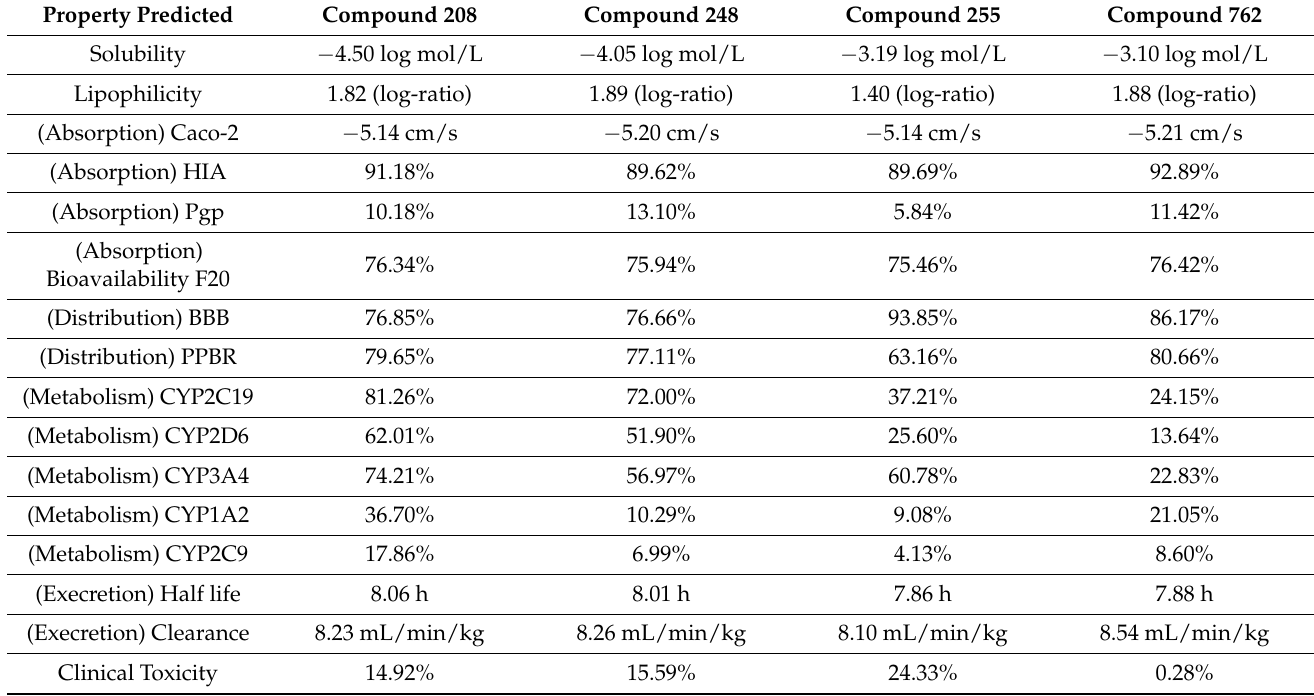
Table 9. ADMET properties of top hits predicted via MPNN